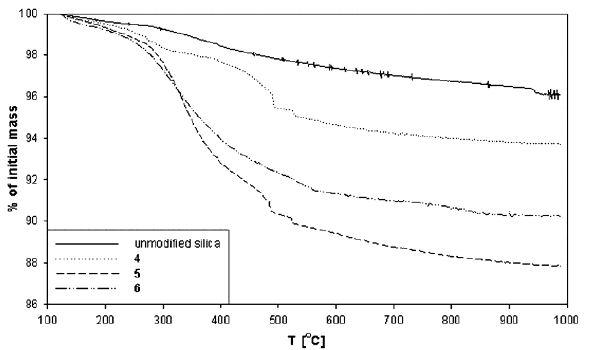
Figure 6. Adjusted curve emphasizes the mass loss. Table 3. Calculations for the grafting process of different capping reagents on the MCM-41 silica’s surface. Capping